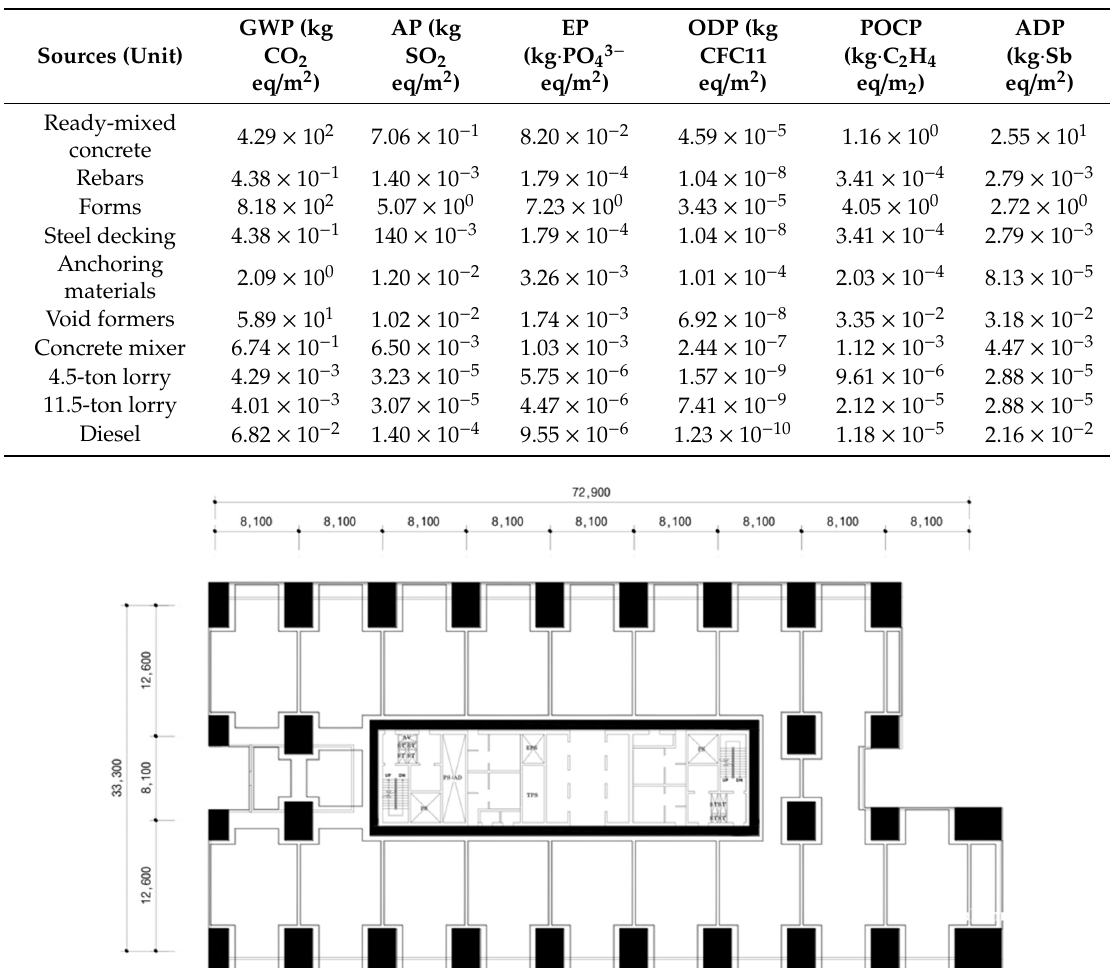
Figure 3. Typical floor plan of the studied building.